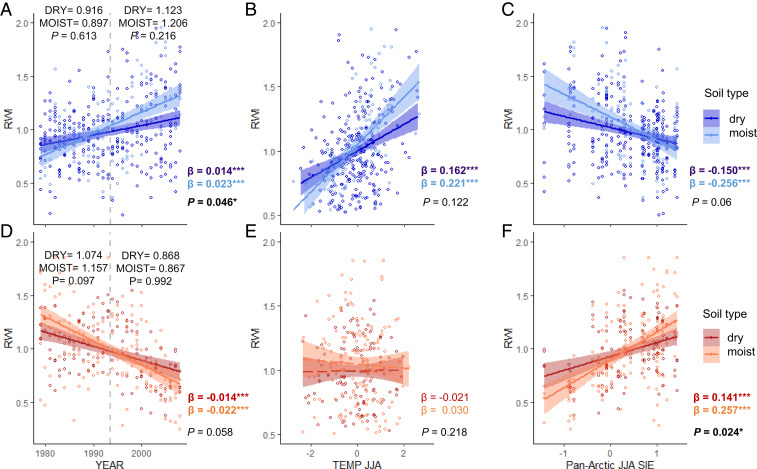
Trends in shrub growth, summer temperature, and sea ice relationships for two groups of responders aggregated per soil moisture type. Standardized annual growth (RWI) of increasers (A–C; blue) and decreasers (D–F; red) between dry (dark colors) and moist (light colors) soil moisture types, together with linear relationships (and associated 95% confidence intervals) between shrub chronologies and (B and E) summer temperature (TEMP JJA) and (C and F) summer Pan-Arctic sea ice extent (JJA SIE). Nonsignificant trends are marked by dashed lines. Significant levels for differences between the slopes is presented in the Bottom Right corner of each plot. Values marked in bold indicate a statistically significant difference (P < 0.05). In A and D plot P values from Welch’s two-sample t test are reported on the Top of the plot together with mean RWI per soil moisture type for early (1979 to 1993) and recent (1994 to 2008) periods. Vertical gray dashed line (A and D) divides early and recent periods. Linear regression slopes with significant levels (*P < 0.05, ***P < 0.001) for each relationship and entire study period (1979 to 2008) are reported in colored font (dry soil, dark font; moist soil, light font). N increasers = 9 (270) and 4 (120) for dry and moist chronologies (mean annual RWI), respectively. N decreasers = 4 (120) and 5 (150) for dry and moist chronologies (mean annual RWI), respectively.